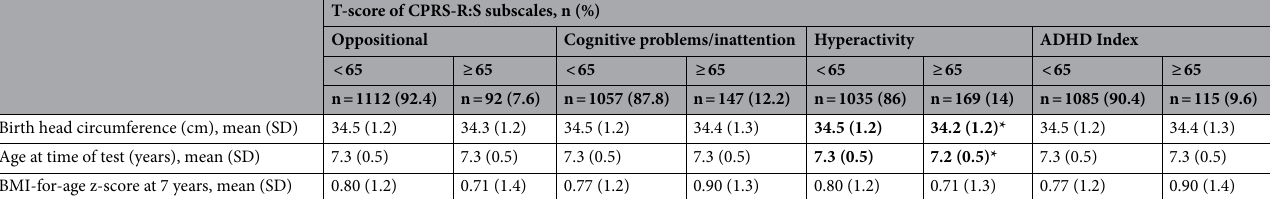
(Table 1). Overall, children of younger mothers, with higher BMIs or who reported smoking during pregnancy were more likely to present elevated T-scores (≥ 65) on the CPRS-R:S subscales. Conversely, ADHD symptoms were less frequent in the children of mothers with higher social and educational classes, and in those who breast- fed longer (except for the Oppositional subscale). There was no difference in child ADHD-related outcomes in terms of maternal anaemia or iron status. The women of the cohort included in this analysis were older, had a higher level of education and social class, and tended to be smokers more than non-participating women (n = 946; all p < 0.05, data not shown). The general characteristics for women in each cohort are shown in Supplementary Table 1 and highlight the diversity of the different cohorts. In the univariate linear regression analysis, maternal total log-SF was positively associated with the children’s T-scores on the CPRS-R:S subscales Cognitive problems/Inattention (β: 0.63, 95%CI: 0.06–1.19; p = 0.029) and ADHD index (β: 0.72, 95%CI: 0.20–1.24; p = 0.007). These associations were not present after adjusting for cohort region, mother’s age, pre-pregnancy self-reported BMI, social class, smoking during pregnancy, total iron intake above the RDA (27 mg/d), mode of delivery, parity, breastfeeding duration, children’s sex, age at delivery, birth weight, birth head circumference, children’s age at the time of the test, and BMI-for-age z-score at 7 years of age. We also added Hb levels during the first trimester of pregnancy to the model in order to evaluate the independent impact of SF levels on outcomes and vice versa. Similarly, no association was observed in the analyses stratified by first and second trimester of pregnancy (Table 2). Hb levels in the first and third trimester of pregnancy were